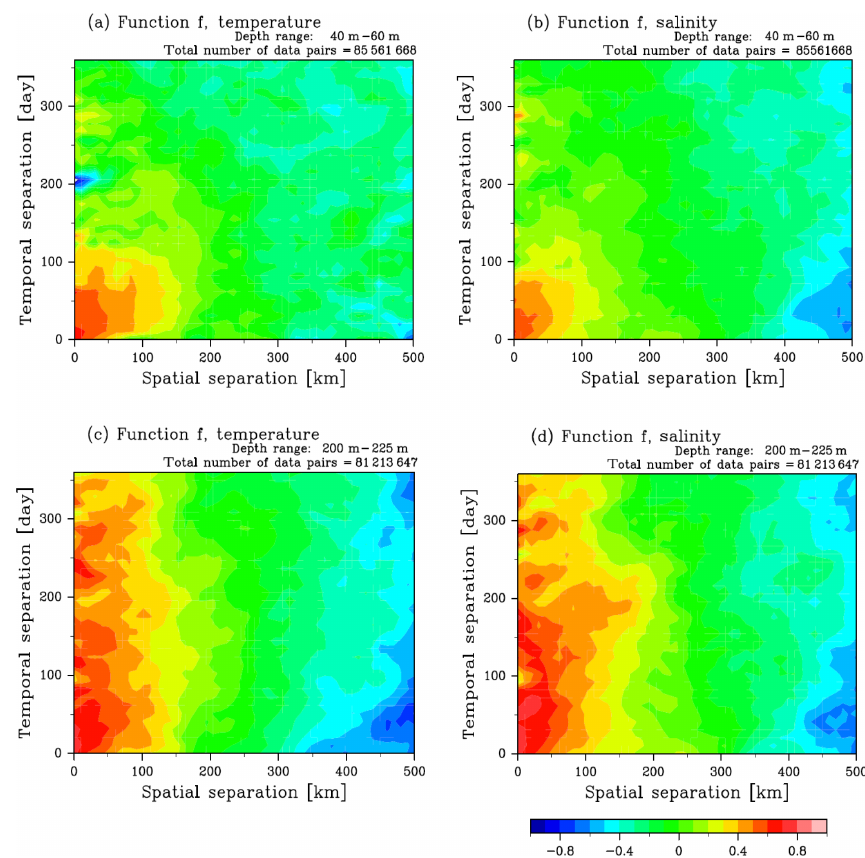
Figure 4. Function f (normalized root mean square difference) of temperature (a, c) and salinity (b, d) in 40–60m (a, b) and in 200– 225m (c, d) depth ranges as a function of spatial (km) and temporal (days) separations of measurement pairs. The color scale is common to the